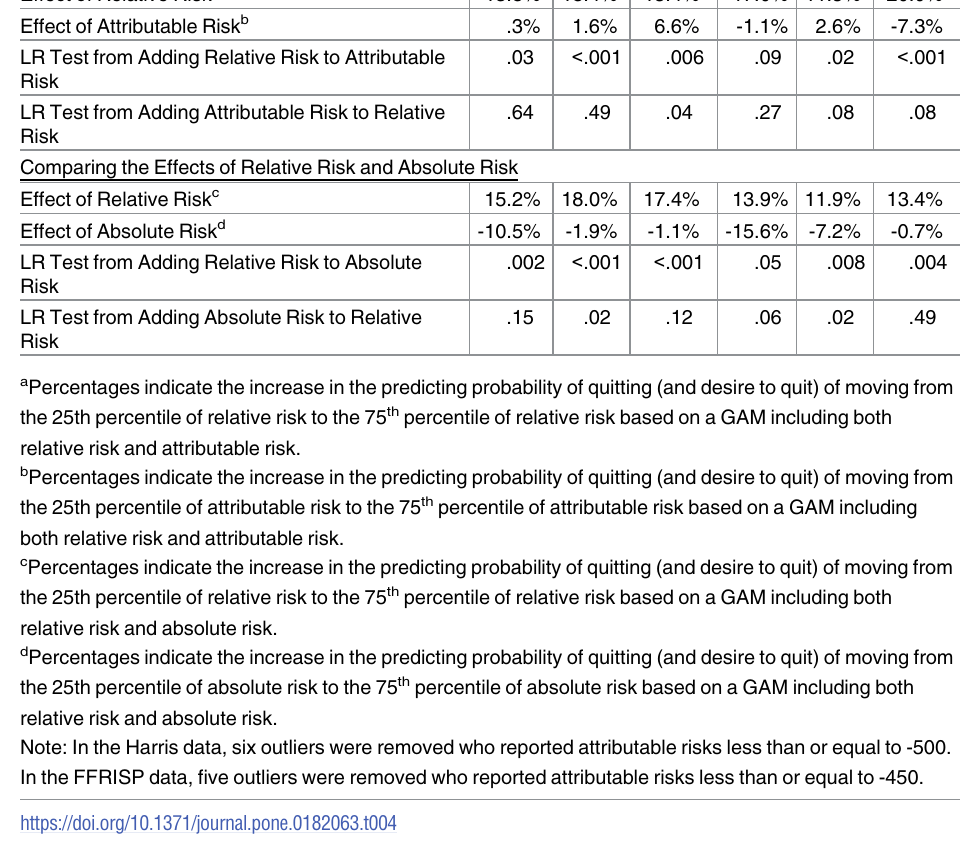
Table 4. Comparing risk measures:SRBI, Harris Interactive, and FFRISP Surveys. Comparing the Effects of Relative Risk and Attributable Risk Comparing the Effects of Relative Risk and Attributable Risk Effect of Relative Risk a